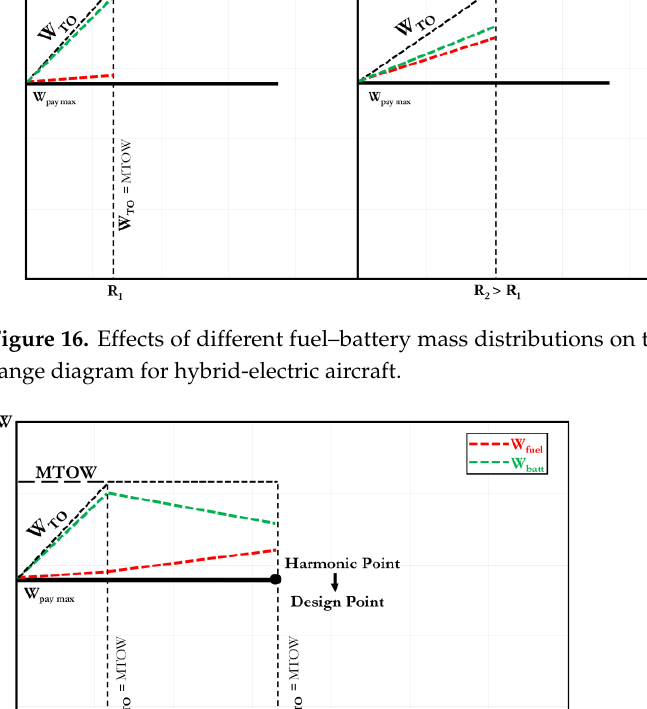
Figure 16. Effects of different fuel – battery mass distributions on the first segment of the payload – range diagram for hybrid-electric aircraft.